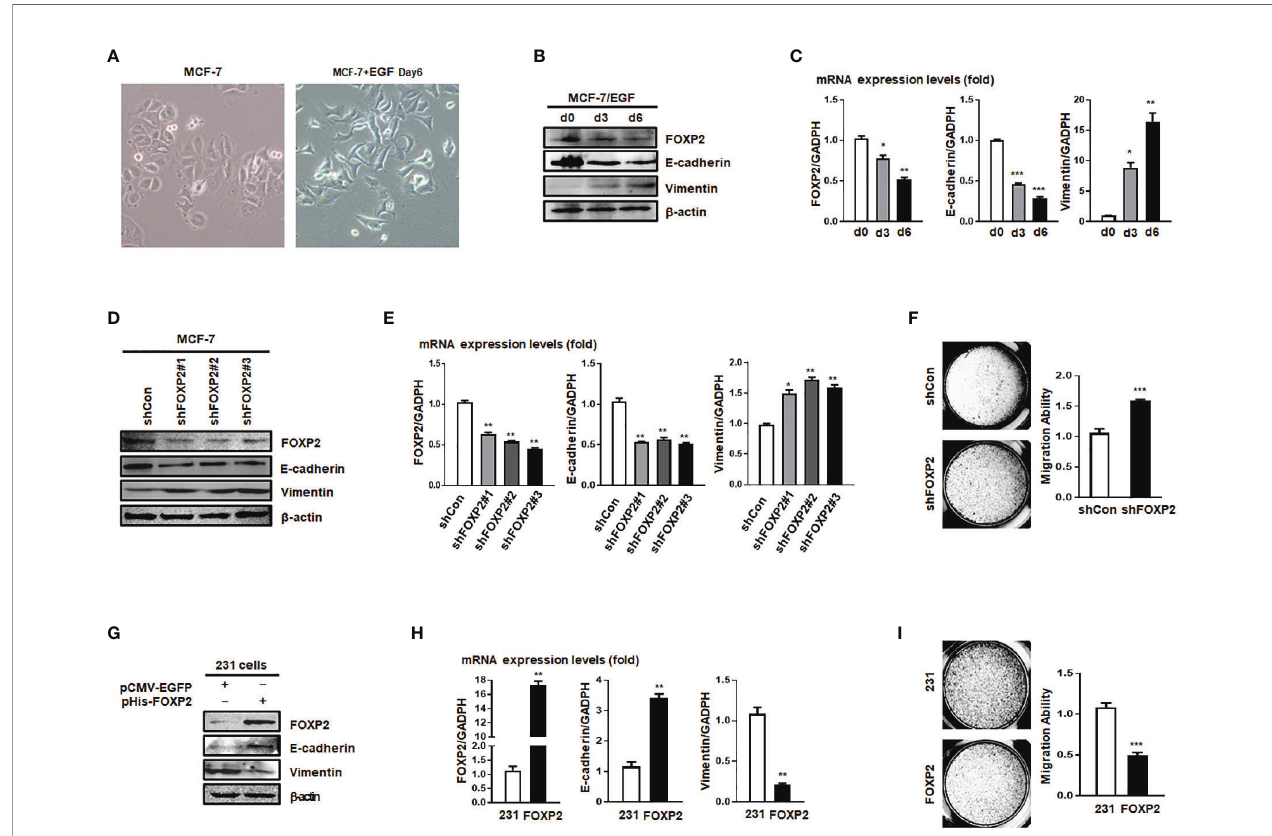
FIGURE 2 | FOXP2 inhibited the EMT of breast cancer cells. (A) The changes of the morphology at day 6 post epidermal growth factor (EGF) treatment (100 ng/ml) in MCF-7 cells were pictured by TE2000S (Nikon, 200×). (B, C) The expression of FOXP2 was downregulated during EGF-induced epithelial-mesenchymal transition (EMT) in MCF-7 cells. MCF-7 cells were treated with EGF (100 ng/ml) and harvested at different time points (day 0, day 3, day 6) post the treatment. The levels of FOXP2, E-cadherin, and Vimentin were examined by Western blotting (B) and qPCR (C) , respectively. (D – F) Knockdown of FOXP2 enhanced EMT in MCF-7 cells. MCF-7 cells were infected with one of lentiviral vectors expressing various FOXP2-speci fi c shRNA (Lv-shFOXP2#1, #2, #3) or the control lentiviral vector (Lv-shCon). The stable FOXP2-knockdown MCF-7 cells were selected and harvested for protein and total RNA preparation. The levels of FOXP2, E-cadherin, and Vimentin were examined by Western blotting (D) and qPCR (E) . The migration ability of Lv-shCon-infected MCF-7 cells (shCon) and Lv-shFOXP2#2-infected cells (shFOXP2) was measured by the Transwell invasion test and the statistical data are shown on the right (F) . (G – I) Overexpression of FOXP2 abolished the mesenchymal phenotype of MDA-MB-231 cells. MDA-MB-231 cells were transfected with pHis-FOXP2 or the control vector pCMV-EGFP. The levels of FOXP2, E-cadherin, and Vimentin were examined by Western blotting (G) and qPCR (H) . The migration ability of control vector transfected MDA-MB-231 cells (231) and FOXP2-expressing MDA-MB- 231 cells (FOXP2) was measured by the Transwell invasion test and the statistical data are shown on the right (I) . The asterisks indicate statistically signi fi cant changes: *P ≤ 0.05, **P ≤ 0.01, and ***P ≤